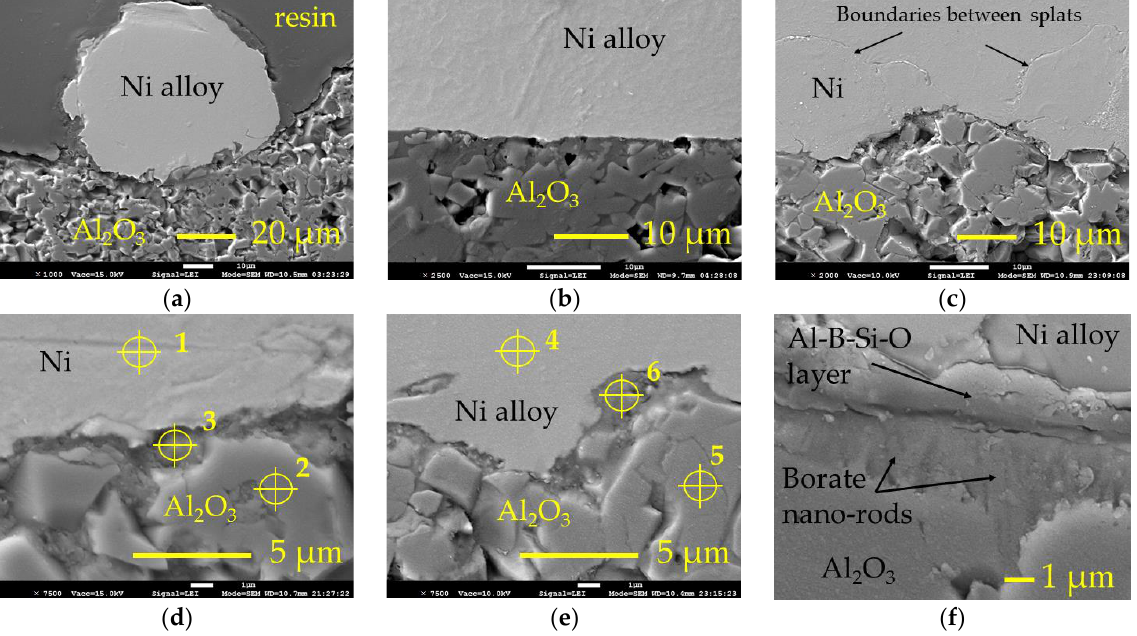
Figure 4. SEM micrographs of the thermally sprayed samples’ cross sections: ( a , b )—single splat and layer, respectively, of the self-fluxing Ni-based alloy on the surface of Al 2 O 3 boronized at 950 ◦ C (after thermal spraying and post-heating at 1200 ◦ C for 180 s); ( c )—thermally sprayed layer of the pure nickel on the surface of Al 2 O 3 boronized at 950 ◦ C; ( d , e )—interface between the pure nickel and Ni-based alloy, respectively, deposit and ceramic substrate with marked points of EDS analysis; ( f )—intermediate layer between Ni-based alloy deposit and borate layer; Ni—pure nickel;